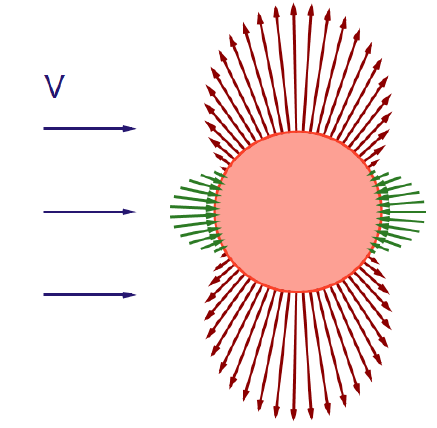
Fig. 4. Pressure coefficient distribution of an irrigation flow of an ideal